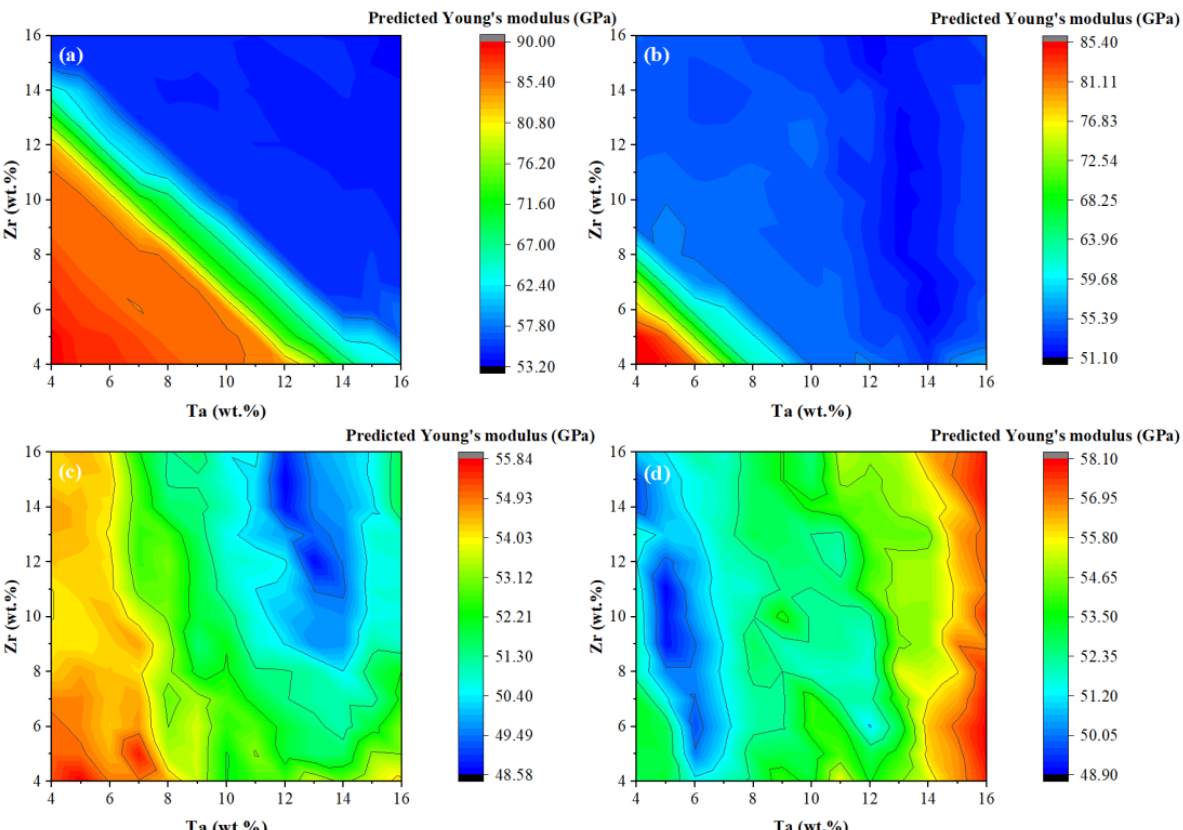
Figure 10. Predicted Young ’ s modulus of Ti alloy systems by machine learning: ( a ) Ti – 12Nb – x Ta – y Zr, ( b ) Ti – 18Nb – x Ta – y Zr, ( c ) Ti – 24Nb – x Ta – y Zr, and ( d ) Ti – 30Nb – x Ta – y Zr.